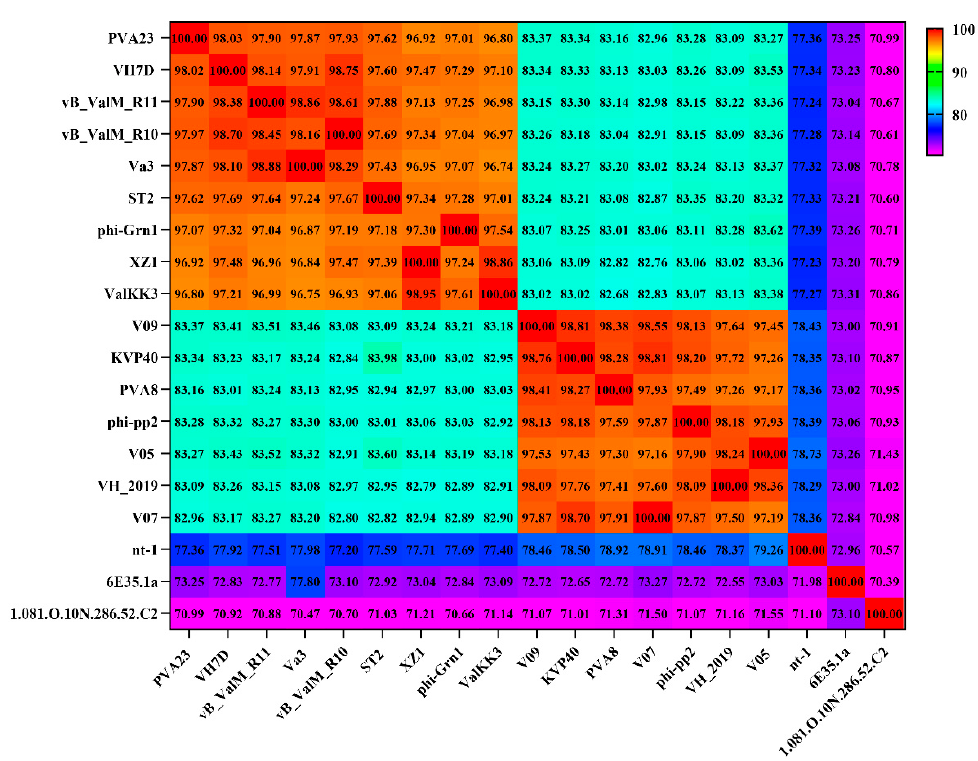
Figure 7. Average nucleotide identity heatmap. The percentage identity values range from 70% (purple) to 100% (red).